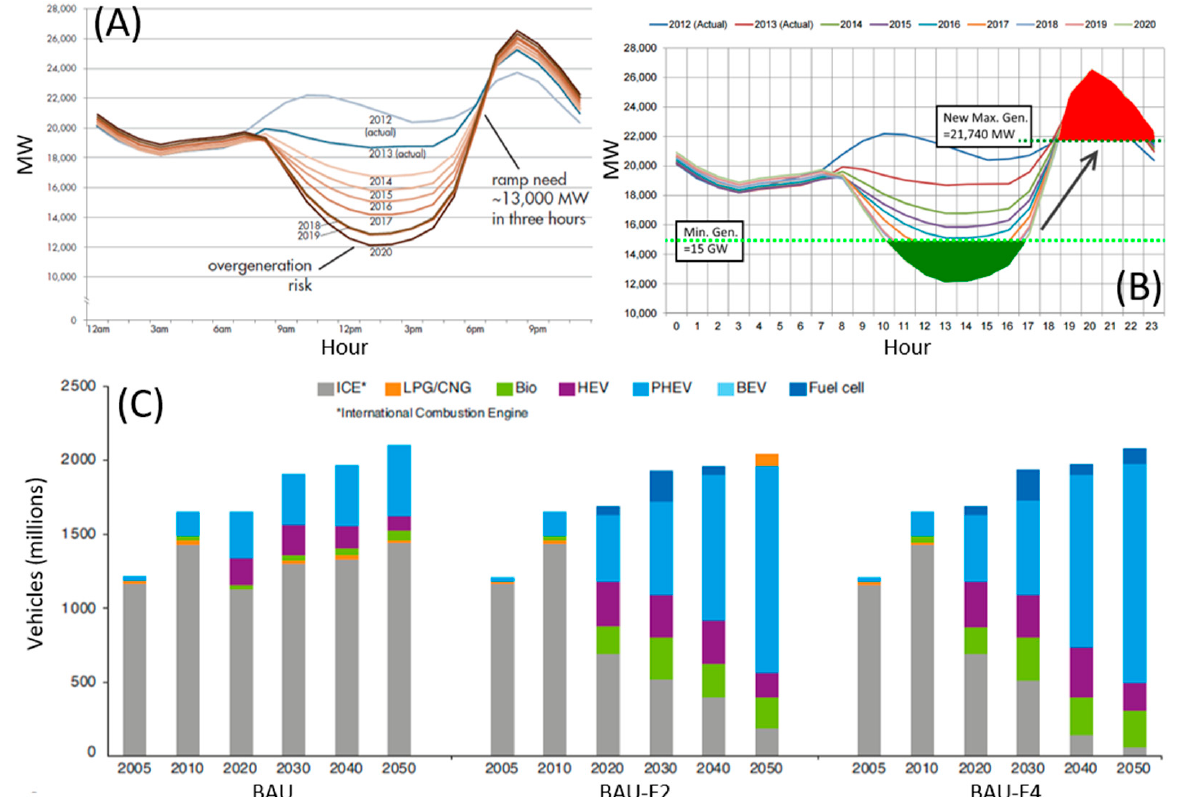
Figure 1. ( A ) Difference between electricity demand and photovoltaic electricity produced during a typical spring day and in different years in the Californian grid; ( B ) “Duck curve” showing energy storage to capture energy during overgeneration risk period (green area) and discharging said energy during peak net load hours (red area); ( C ) Evolution scenarios of the global car fleet, including combustion vehicles (ICE), liquefied or compressed natural gas (LPG/CNG), hybrid (HEV), plug-in hybrid (PHEV), electric with batteries (BEV), electric with fuel cells (Fuel cell). Adapted with permission from [27–29]. Copyright California ISO (2013), Stanford University (2015) and IFP Energies Nouvelles (2018).